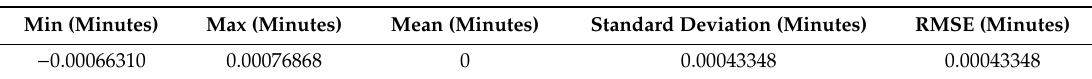
Table 12. Statistical values of the residuals for the latitude coordinates resulting from datum transformation OSPM / ED50 to OSPM / WGS84 based on a conformal